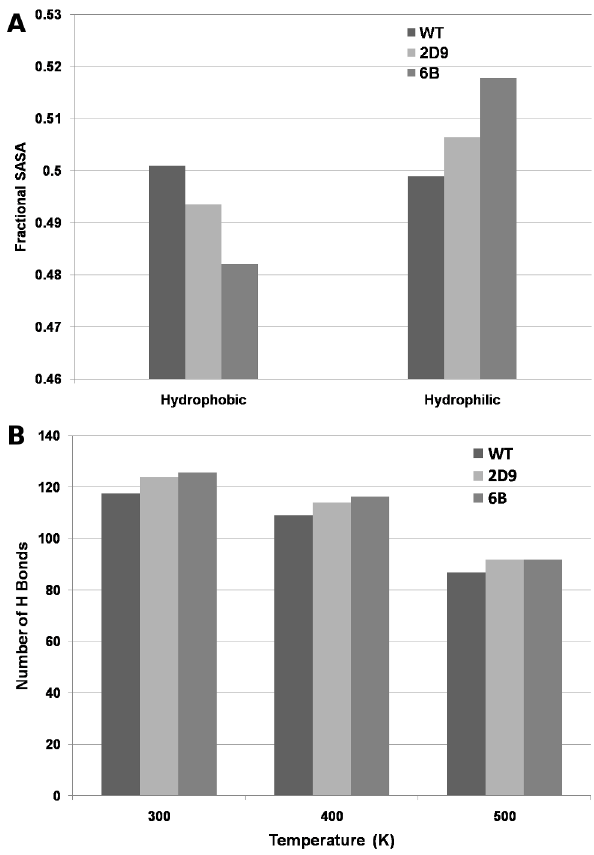
Figure 12. SASA and Average number of Hydrogen bonds per frame. A) Average Fractional Hydrophilic and Hydrophobic SASA values of the frames of MD trajectories for WT, 2D9 and 6B. B) Average number of Hydrogen Bonds per frame for WT, 2D9 and 6B at 300 K, 400 K and 500 K.